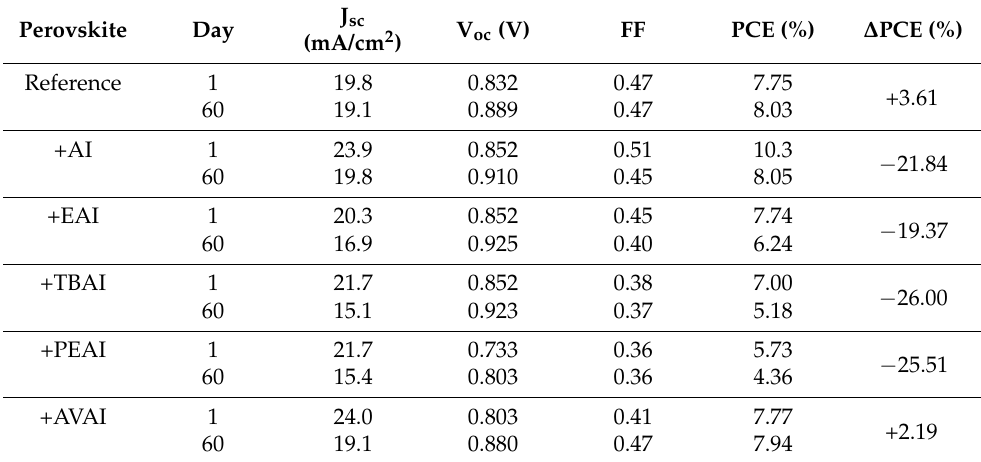
Figure 8. Comparative current density–voltage curves of the 6 carbon-based solar cells under study, under illumination of 100 mW cm − 2 simulated sun irradiation (1.5 AM) at the first day of their fabrication and after 60 days of shelf life. Table 4. Comparative table of electrical parameters derived from the J-V curves of the C-PSCs under study at the first day of their fabrication and after 60 days of shelf